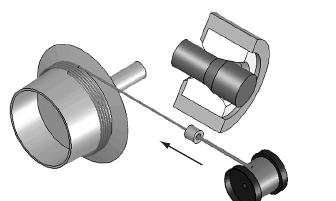
Figure 1. Scheme of the wiredrawing process.